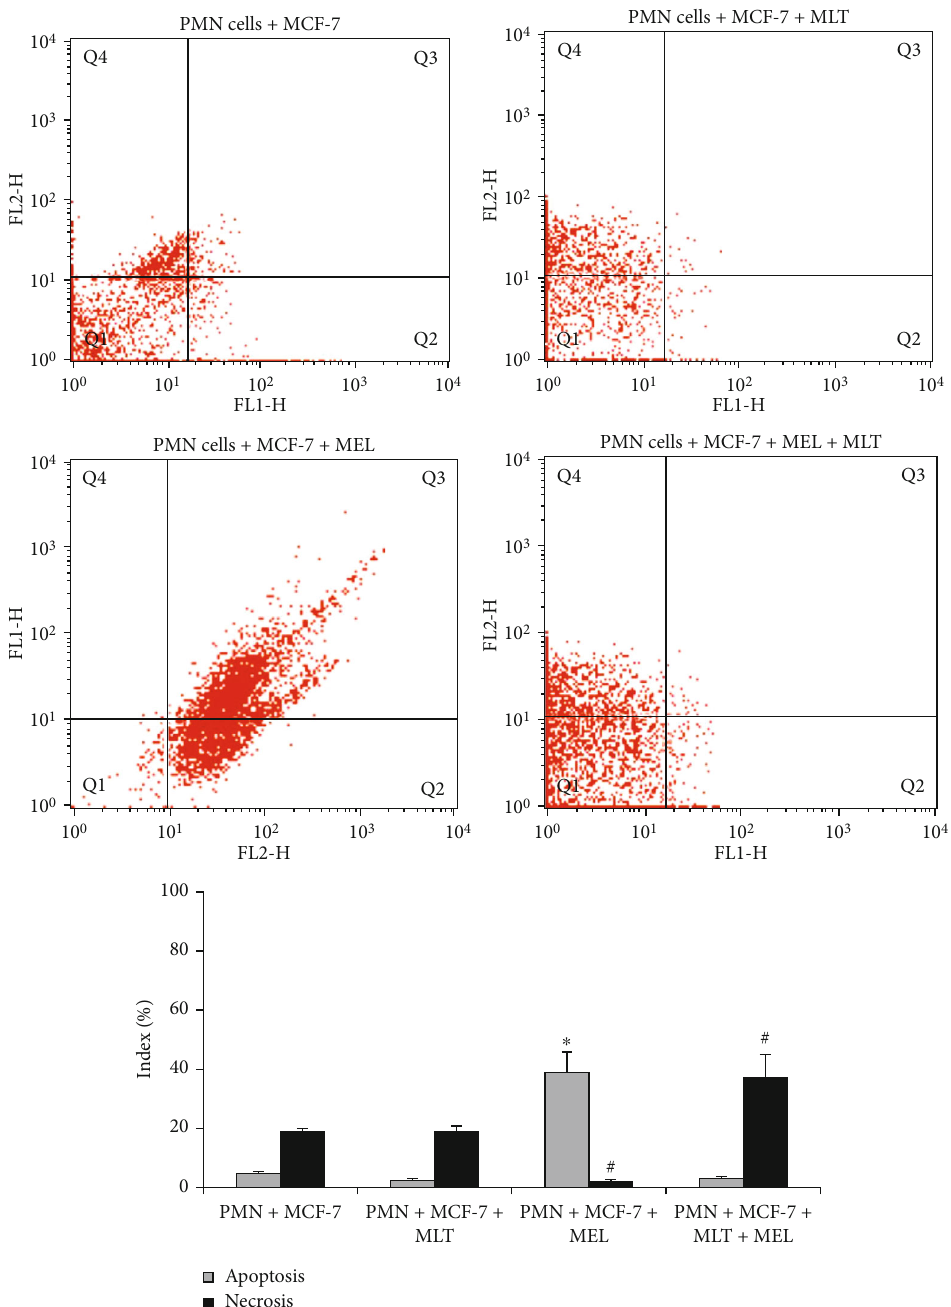
Figure 2: Apoptosis and necrosis in coculture of PMN cells and MCF-7 cells after 72 hours of incubation. PMN: polymorphonuclear cells; MCF-7: human breast cancer cells; MLT: melatonin; MEL: microemulsion. Cells were stained with Annexin V/PI and analyzed by fl ow cytometry. In the dot plot, the lower-left (Q1) quadrant corresponds to a viable cell; the lower-right (Q2) and upper-right (Q3) quadrants represent the percentage of apoptosis, and the upper-left (Q4) quadrant is the percentage of necrosis. p < 0 : 05 . ∗ Compared to apoptosis index of PMNs untreated with PMNs treated; # compared to necrosis index of PMNs treated with